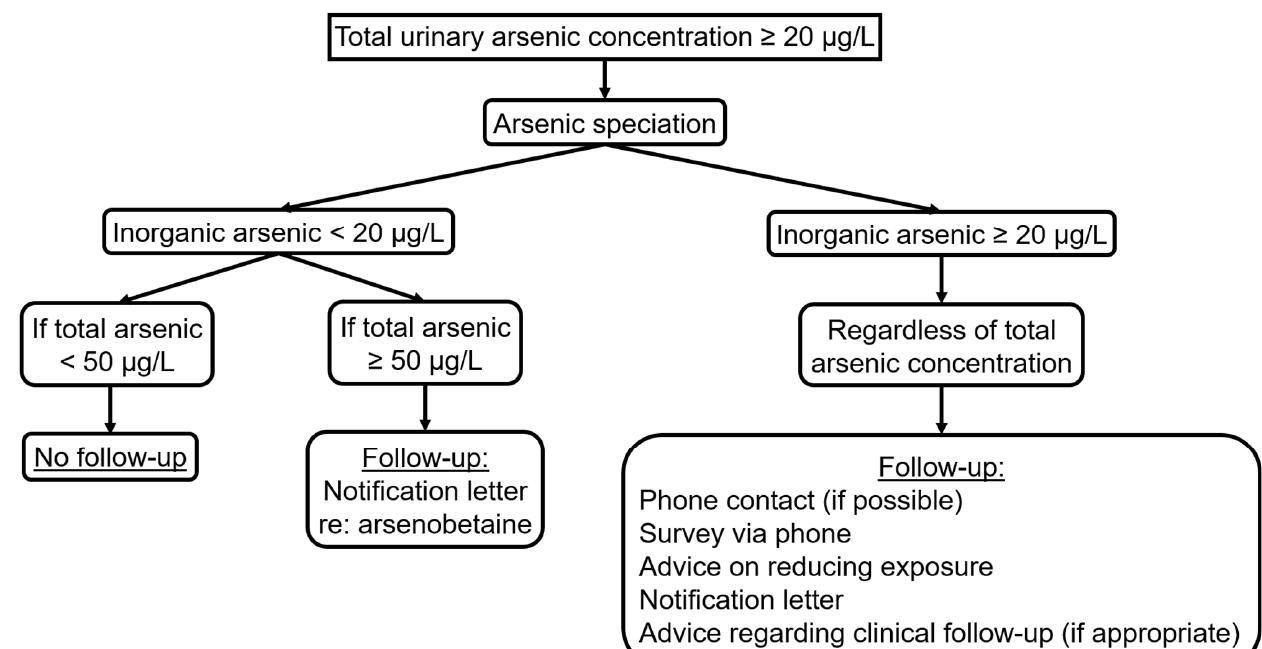
Figure 1. Flow chart of protocol for evaluating and following up on urinary arsenic levels.